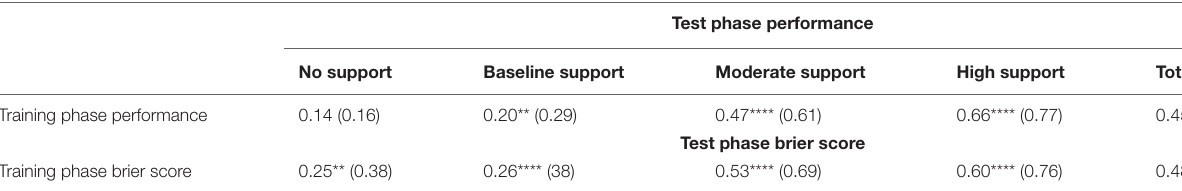
TABLE 5 | Kendall’s Tau and Pearson’s correlations [ τ b ( r )] matrix between training and test phase.